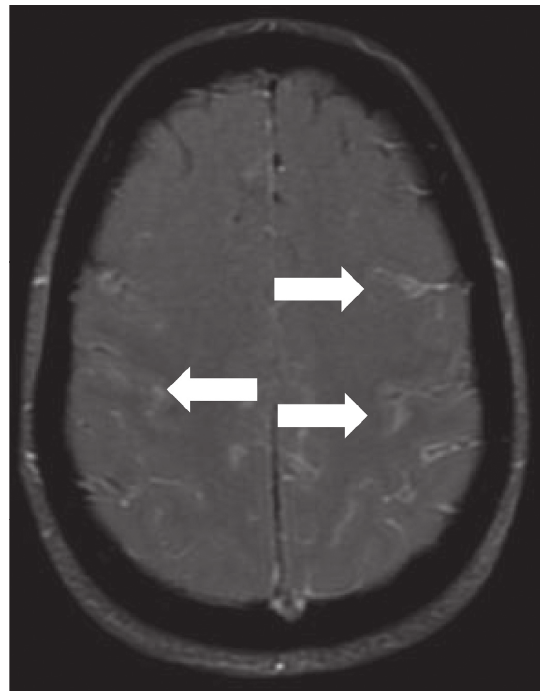
Figure 1: Brain MRI: T1, after gadolinium administration; arrows: leptomeningeal